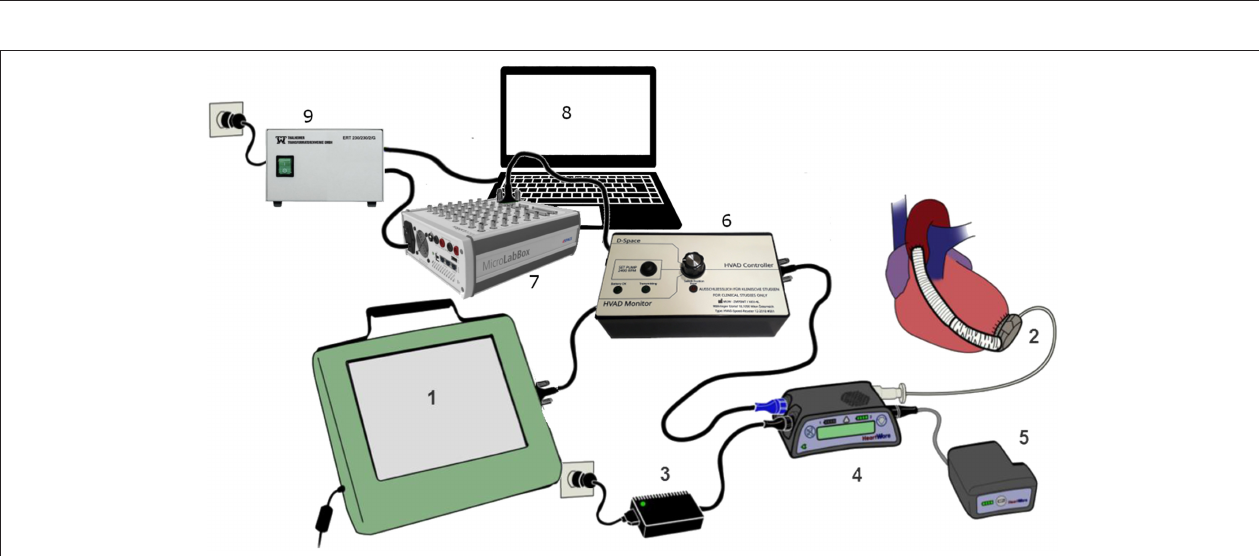
FIGURE 2 | The clinical routine hardware setup of the HVAD (1–5) was modified with the addition of a switchbox (6), the dSpace MicrolabBox (7), a laptop (8), and an isolation transformer (9). The switchbox routes serial transmission to the controller between the monitor, the internal microprocessor and the dSpace based system